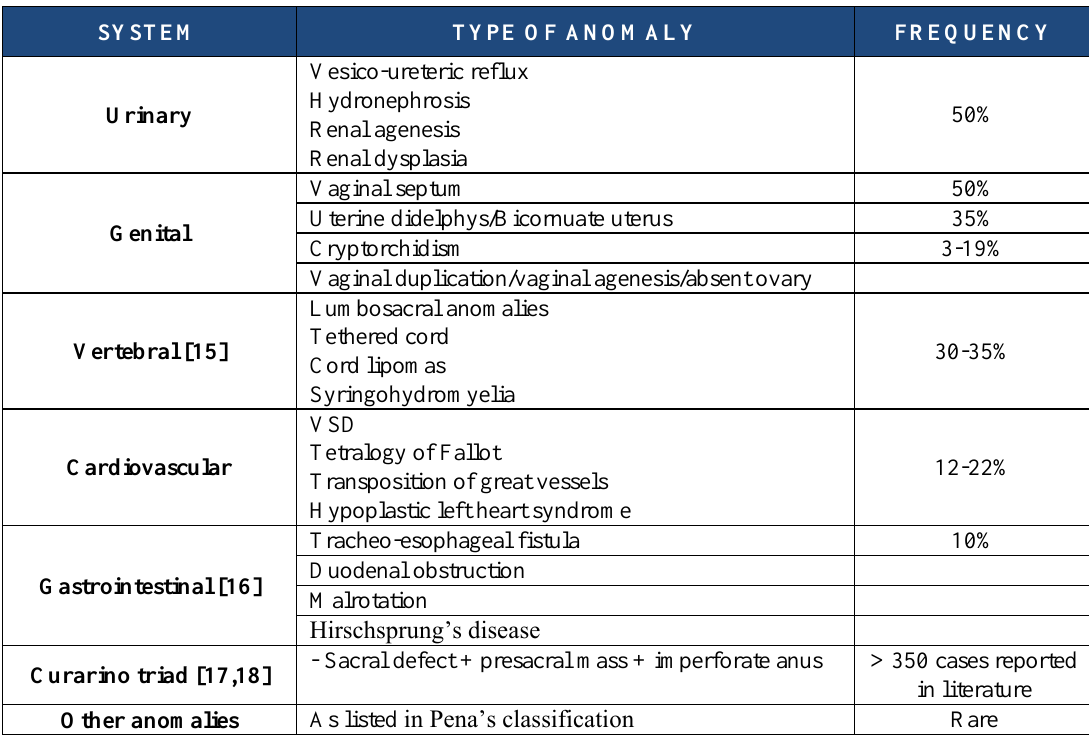
Table 7: Associated anomalies in